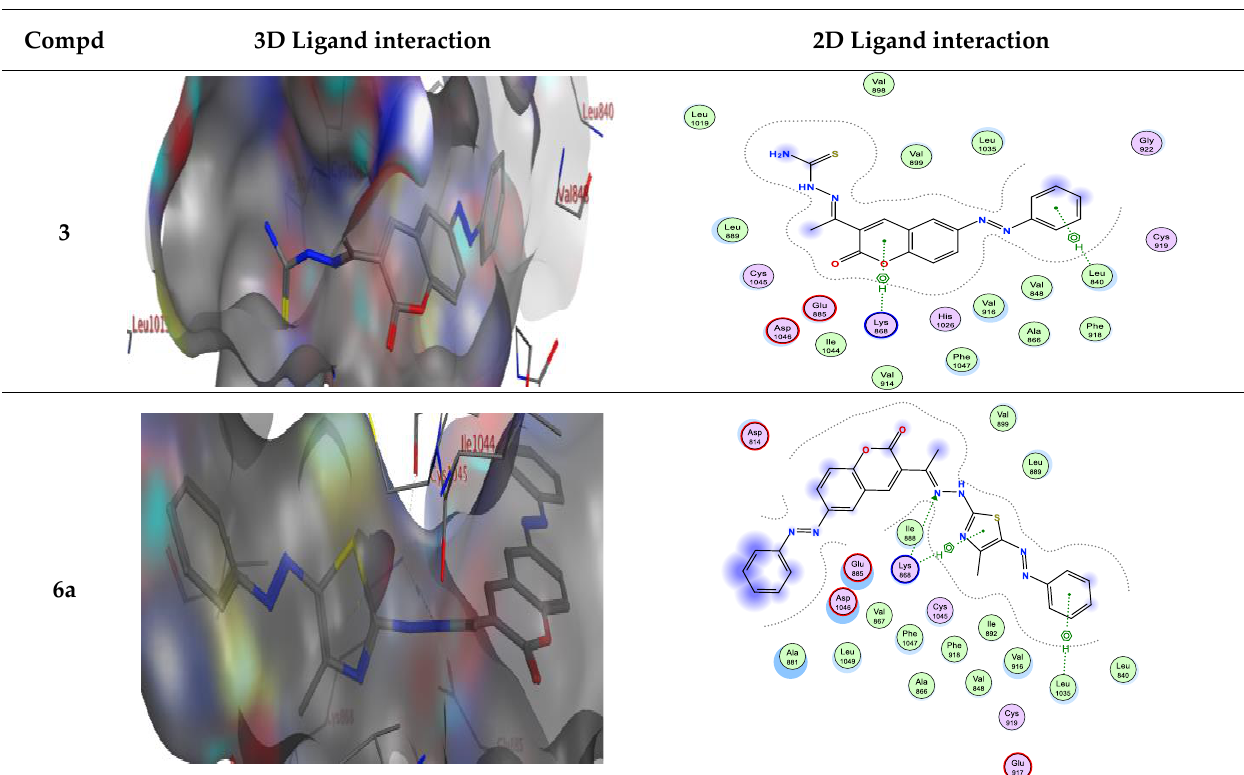
Figure 4. Interactions between ligands in three dimensions (left) and two dimensions (right) within a compound’s binding pocket of 4ASD (type II VEGFR -2 inhibitor) for compounds 3 , 6a – e , 10a – c and 12a – c .